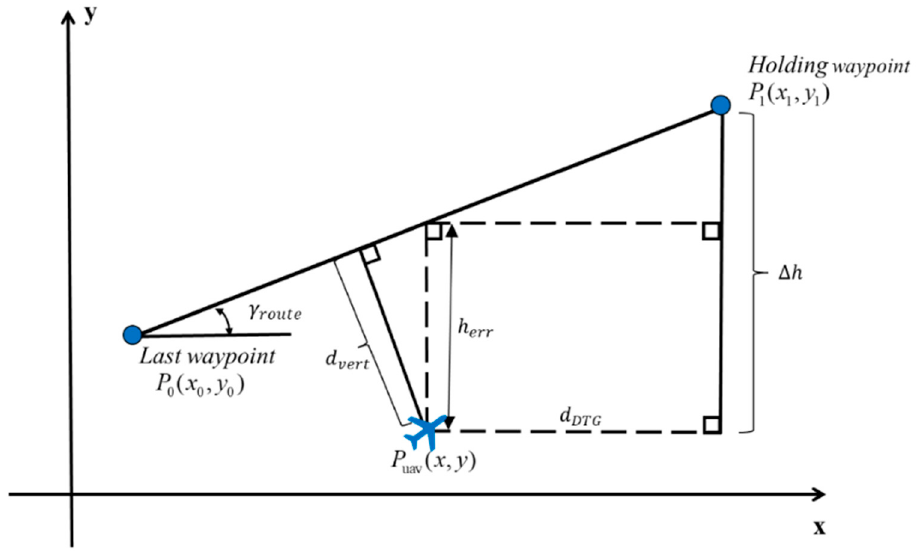
Figure 4. Linear guide in vertical direction.